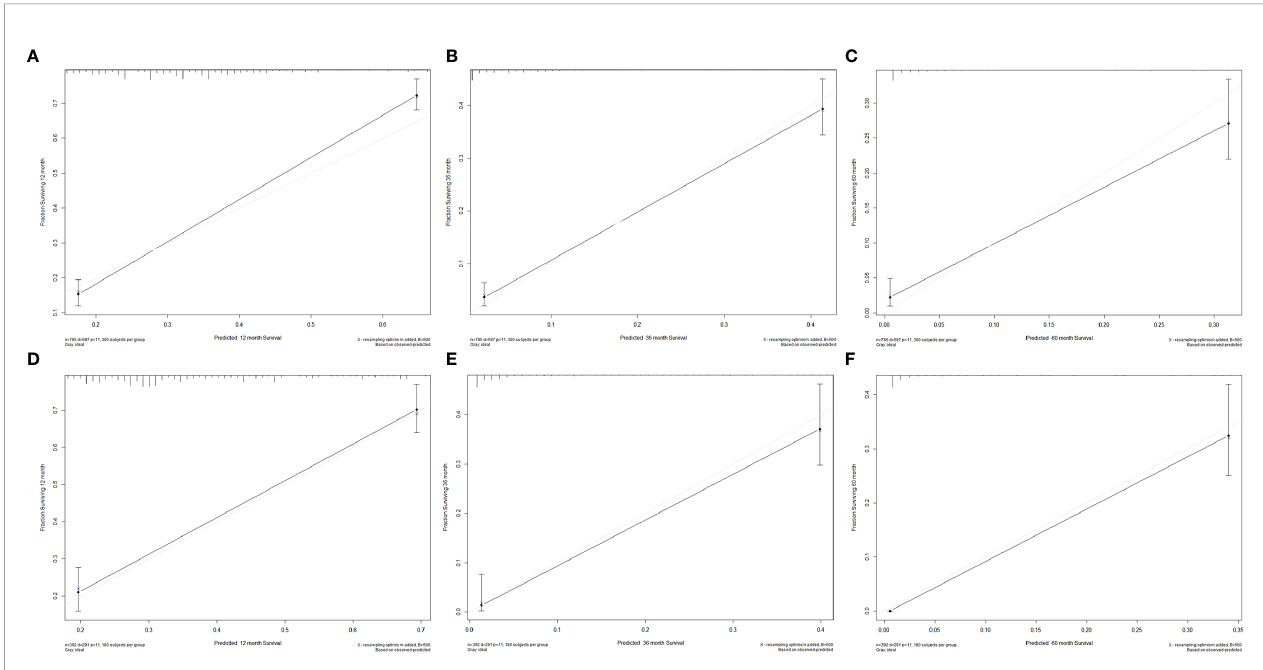
FIGURE 4 | Calibration plots for 1-, 3-, and 5-year CSS in the (A – C) training cohort and (D – F) validation